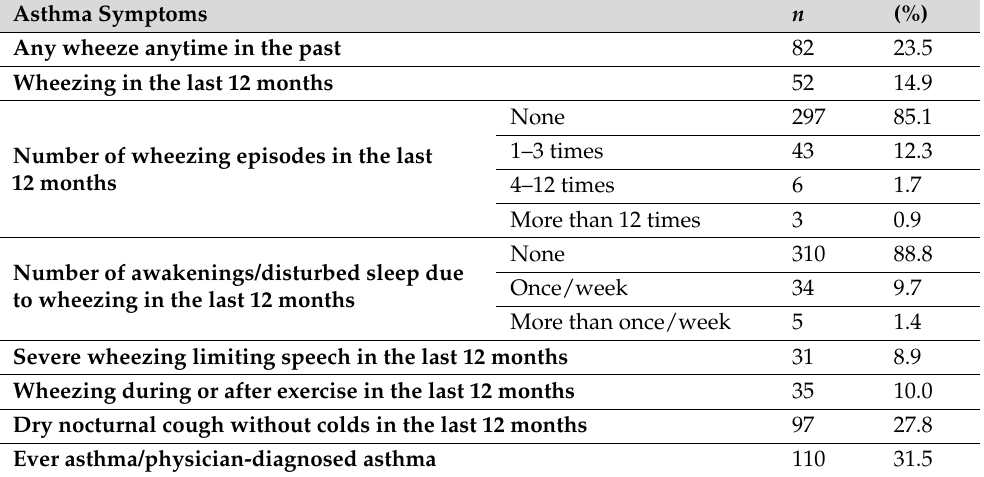
Table 2. Prevalence of asthma/asthma symptoms according to ISAAC in children/adolescents in Rabigh city.